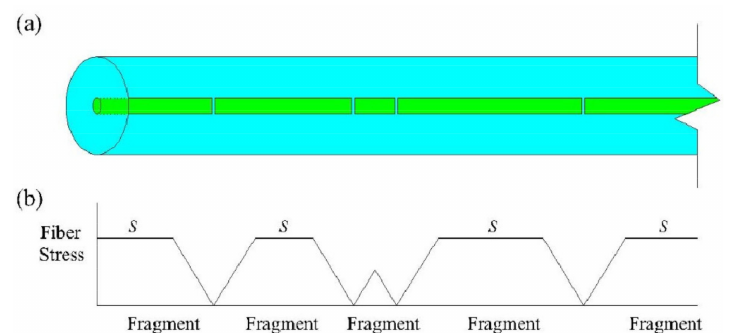
Figure 5. ( a ) Schematic of the random fracture distribution of a single fiber, ( b ) stress distribution during fiber